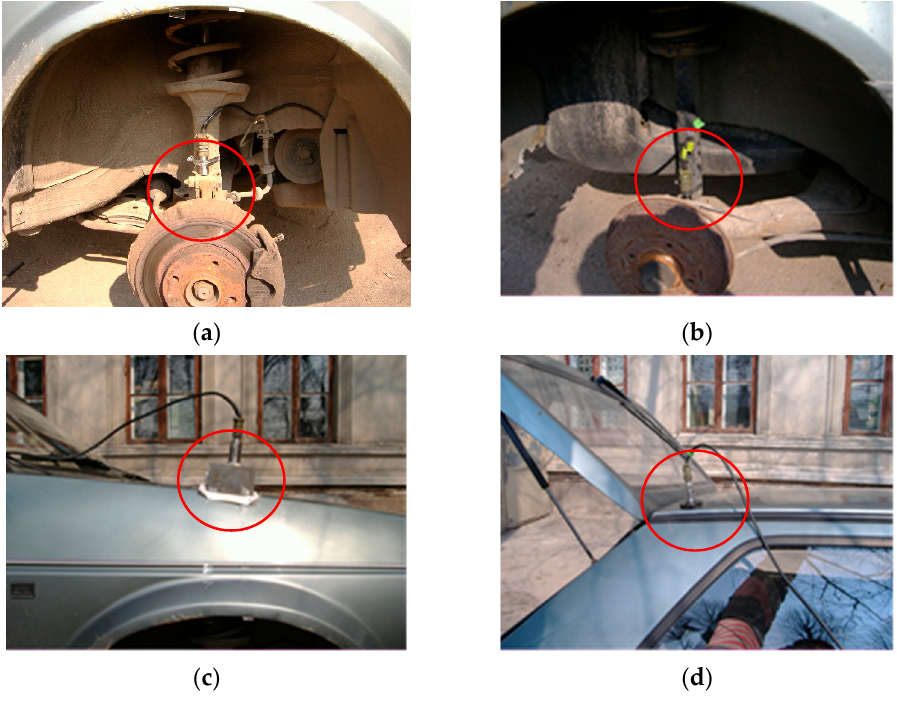
Figure 24. Mounting of sensors for measuring vibrations of unsprung mass: ( a )—front suspension, ( b )—rear suspension; and sprung mass: ( c )—on the front fender, and ( d )—on the roof.